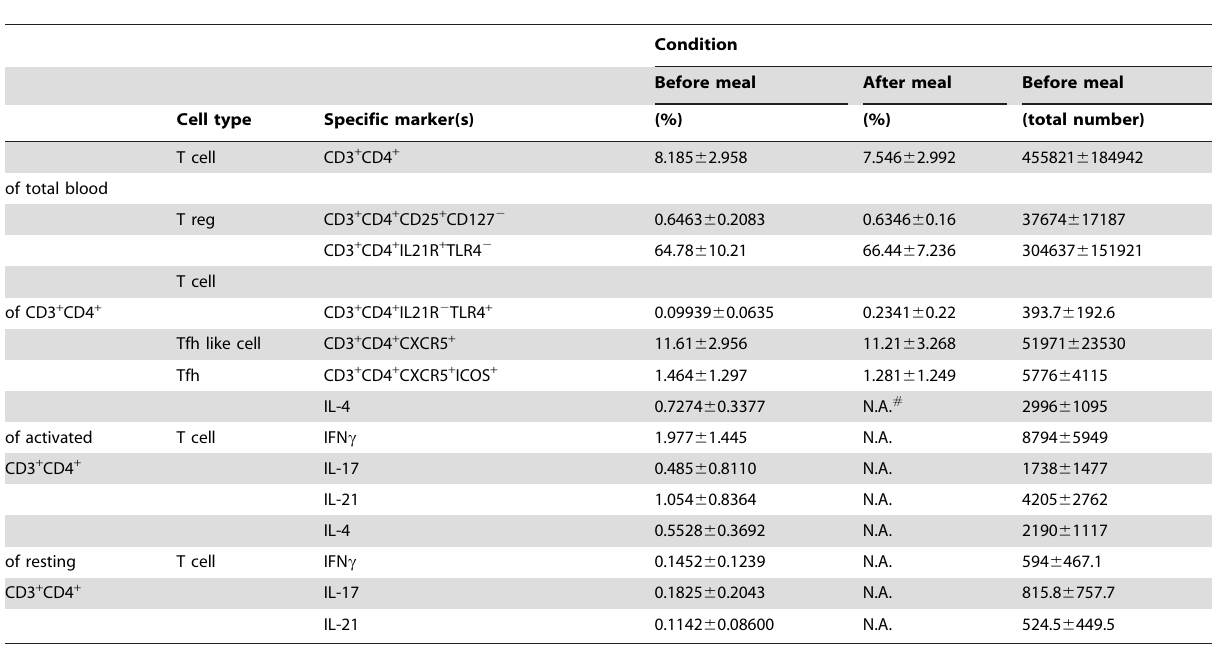
Table 3. Peripheral blood T cells. Data is displayed as mean 6 standard